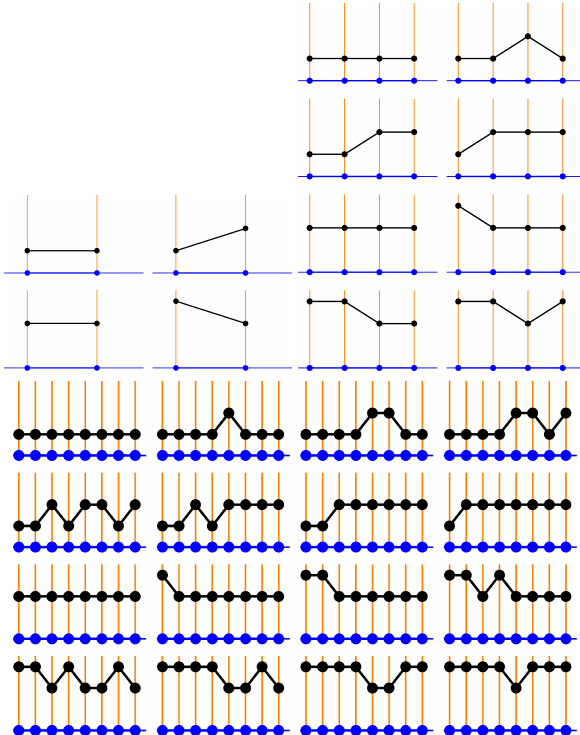
Figure 8. Sections for the example of L ( C ( 3 ) ; z ) for p = 1 ( top left ), p = 2 ( top right ), and p = 4 ( bottom ). The base space is shown as a blue line and Φ ( p ) as blue points on that line. The fibers are shown as orange and the sections are the black dots. The black lines are simply to help the eye when comparing